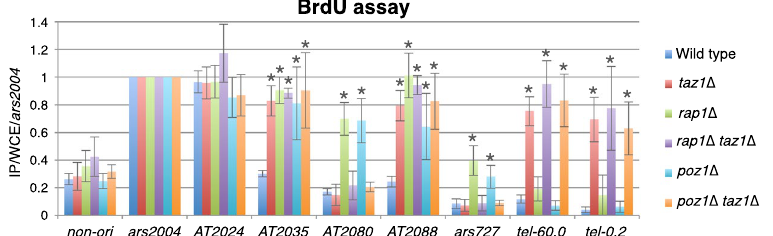
Figure 3. Replication timing defects in rap1 ∆ and poz1 ∆ are Taz1-dependent. The poz1 ∆ strain exhibited replication timing defects similar to those observed in the rap1 ∆ strain. These defects were suppressed by Taz1 deletion. The BrdU incorporation assays were performed as in Fig. 1B. Asterisks indicate a significant change as compared with the wild-type strain ( p < 0.05, Student’s